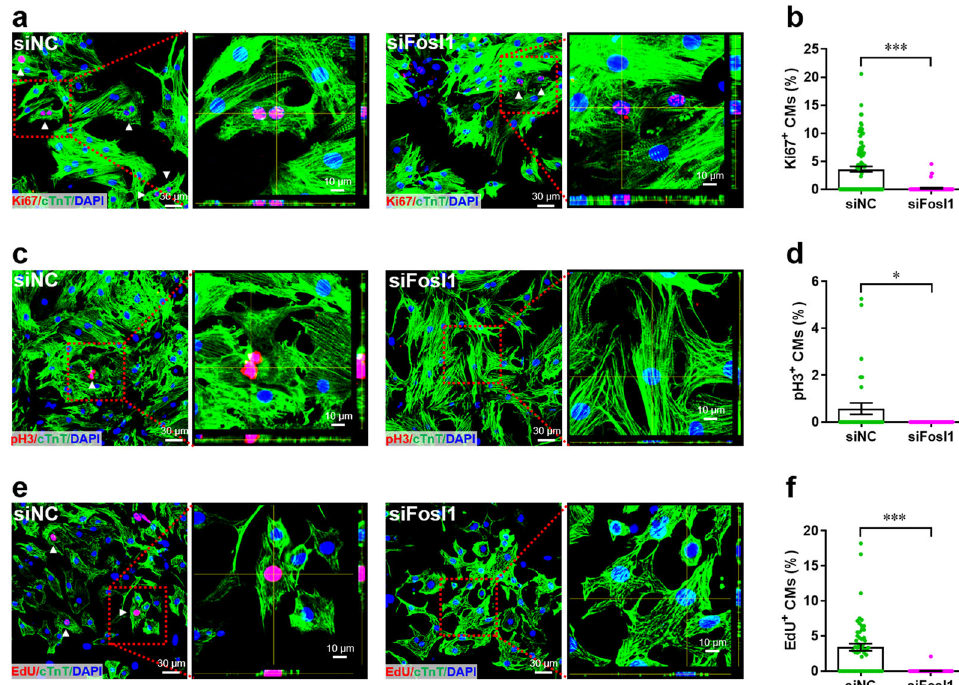
Fig. 7 Fosl1 is required for the proliferation of primary cardiomyocytes. a , b Primary cardiomyocytes were transfected with siFosl1 and siNC for 48 h, followed by Ki67 (red) and cTnT (green) double staining. Representative images ( a ) and quanti fi cation ( b ) of Ki67 + cardiomyocytes are shown ( n = ~60 fi elds from at least 5 wells per group). Representative Z -stack confocal images of Ki67 + cardiomyocytes are shown in right panel of a . c , d Proliferation of primary cardiomyocytes were examined using pH3 (red) and cTnT (green) double staining. Representative images ( c ) and quanti fi cation ( d ) of pH3 + cardiomyocytes are shown ( n = ~30 fi elds from at least 5 wells per group). Representative Z -stack confocal images of pH3 + cardiomyocytes are shown in right panel of c . e , f Proliferation of primary cardiomyocytes were examined using nuclear EdU (red) incorporation assay. Representative images ( e ) and quanti fi cation ( f ) of EdU + cardiomyocytes are shown ( n = ~60 fi elds from at least 5 wells per group). Representative Z -stack confocal images of EdU + cardiomyocytes are shown in right panel of e . All data are presented as mean ± SEM. * p < 0.05, *** p < 0.001 (Student ’ s t